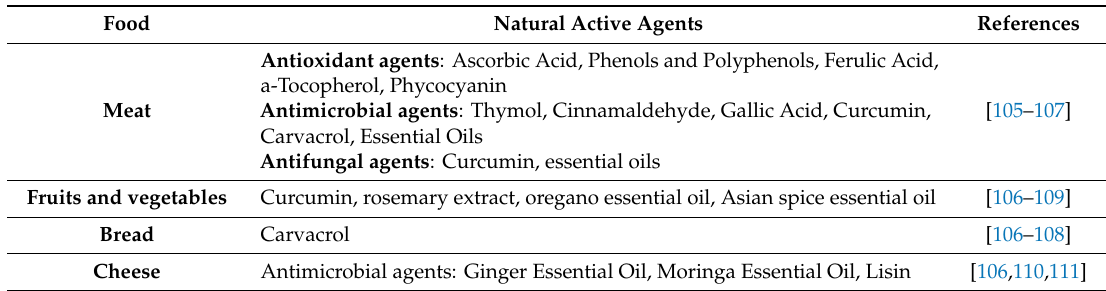
Table 1. Compatibilities between di ff erent sorts of food and biological active agents designed to be loaded into food packaging materials for improving food safety and extending